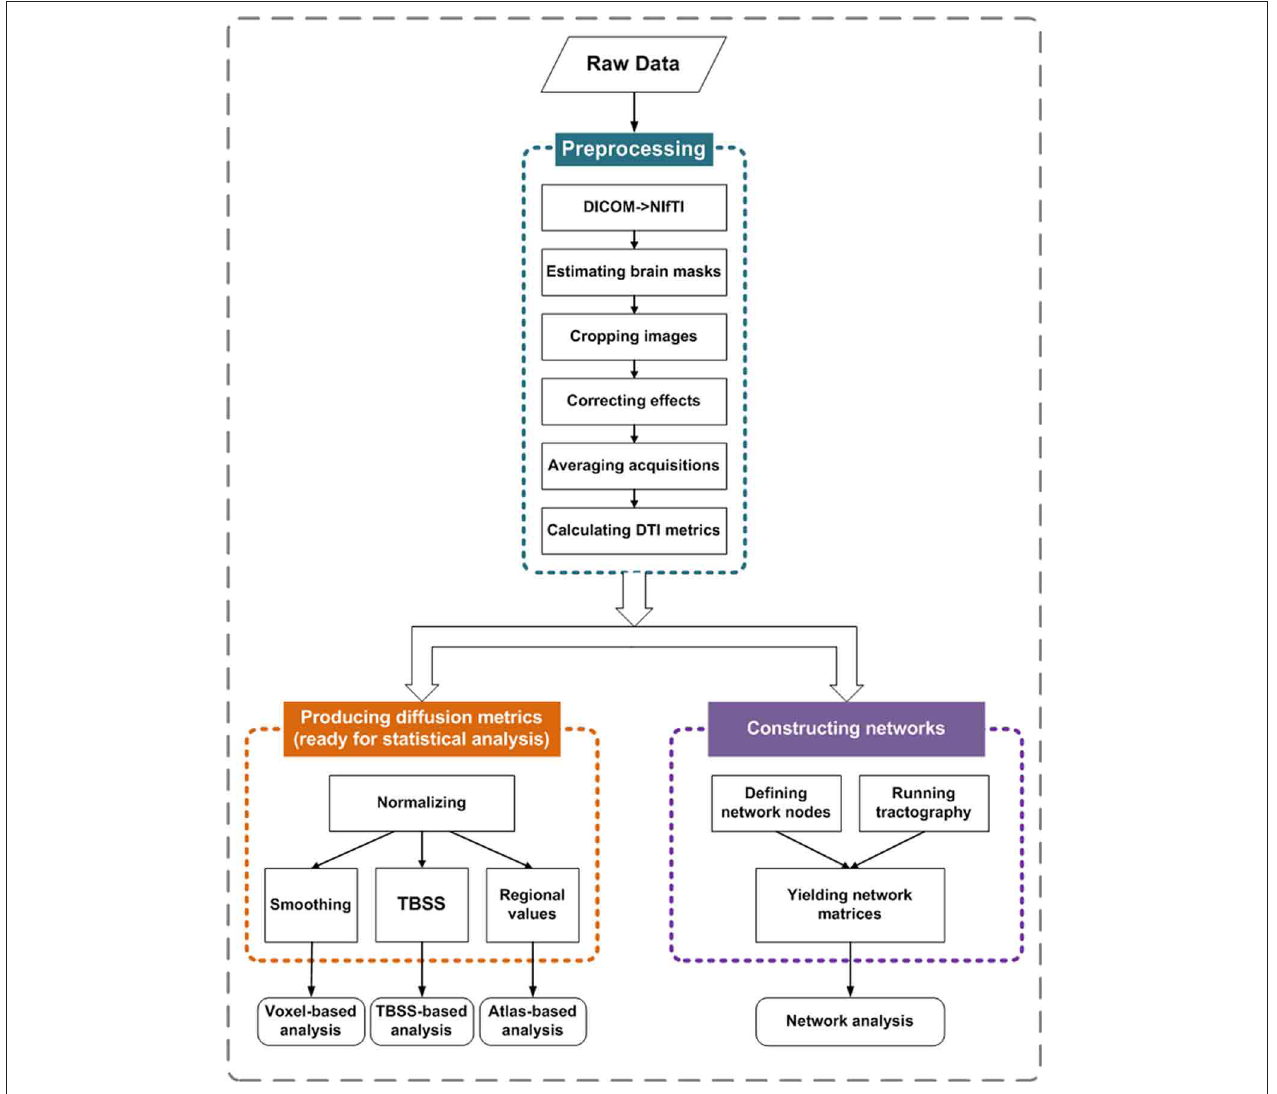
FIGURE 1 | Main procedure for pipeline processing of dMRI datasets in PANDA. The procedure includes three parts: (1) preprocessing; (2) producing diffusion metrics that are ready for statistical analysis; and (3) constructing